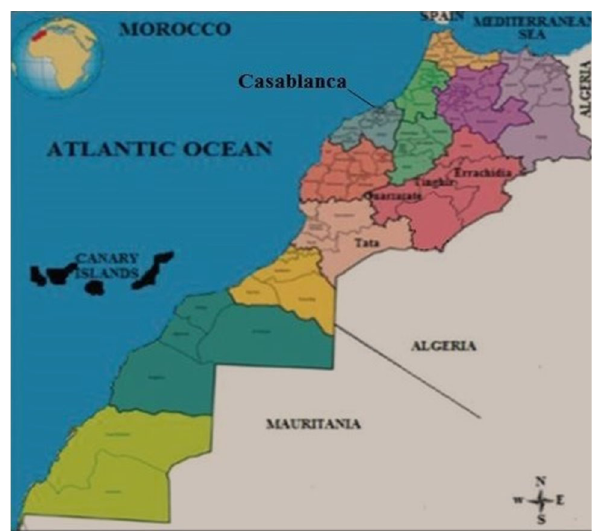
Fig. 1 Localization of study area